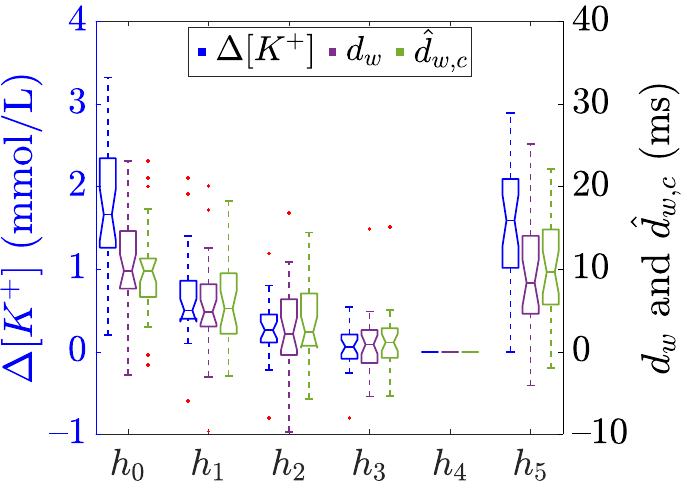
Figure 2. Boxplots showing the distribution of ∆ [ K + ] (blue) and the described π C T -based time warping biomarkers d w (purple) and ˆ d w , c (green), computed at each time points ( h 0 to h 5 ), see Figure 1. The central line of the boxplots represents the median, the edges of the box are the 25-th and 75-th percentiles, and the whiskers extend to the most extreme data points not considered as outliers. The notches represent the 95% confidence interval of the median, calculated as q 2 − 1.57 ( q 3 − q 1 ) / √ n being q 2 the median, q 1 and q 3 are the 25-th and 75-th percentiles, and q 2 + 1.57 ( q 3 − q 1 ) / respectively, and n is the sample size. Finally, red “+” denotes outliers. Data adapted from